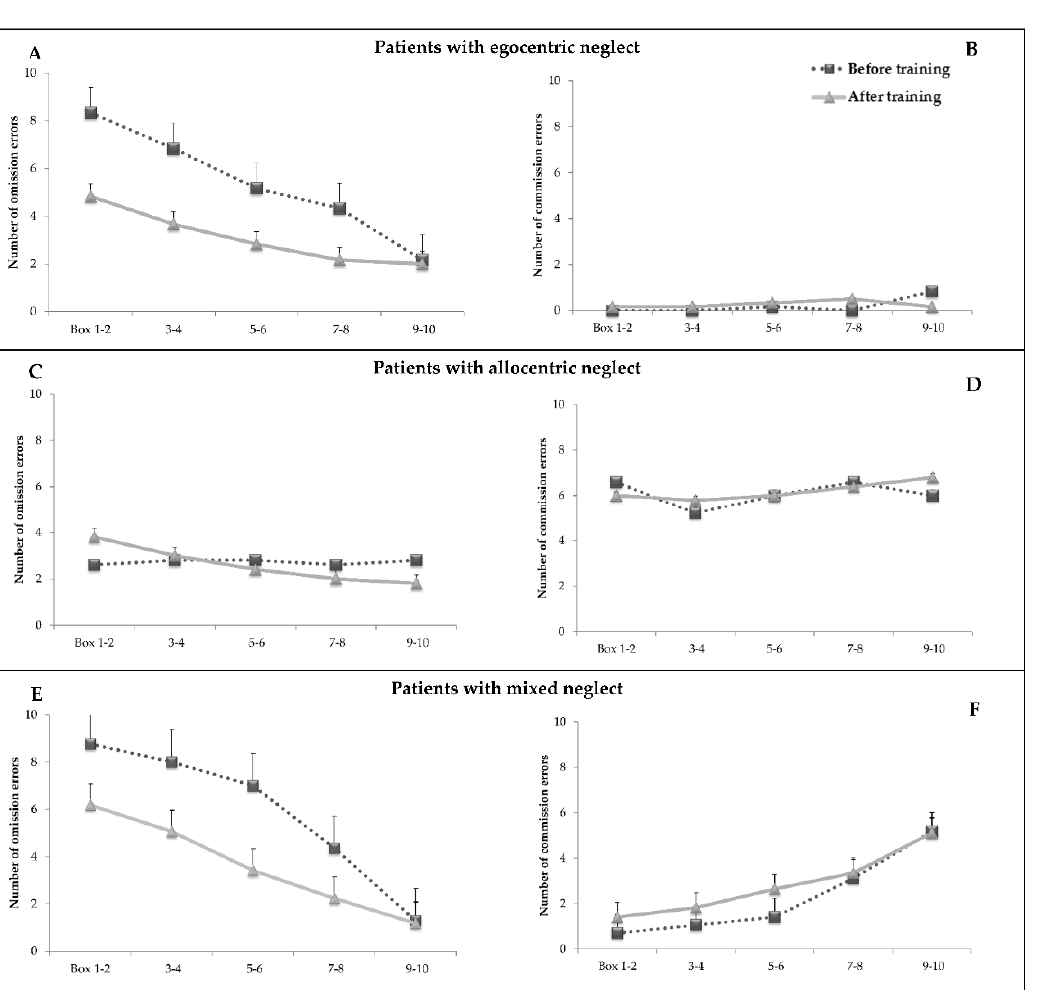
Figure 1. Mean number of omission (left) and commission (right) errors before and after the PA training as a function of space (bars indicate standard errors). Boxes 1–2 are on the extreme left, then boxes 3–4, and so on. Plot ( A ) shows the number of complete apples omitted (omission errors) as a function of space in the group of patients with egocentric neglect ( N = 6). Plot ( B ) shows the number of apples with left-sided holes erroneously marked as a function of space (commission errors). Plots ( C ) and ( D ) show the same data for the group of patients with allocentric neglect ( N = 5). Plots ( E ) and ( F ) show the same data for the group of patients with mixed neglect ( N = 17).